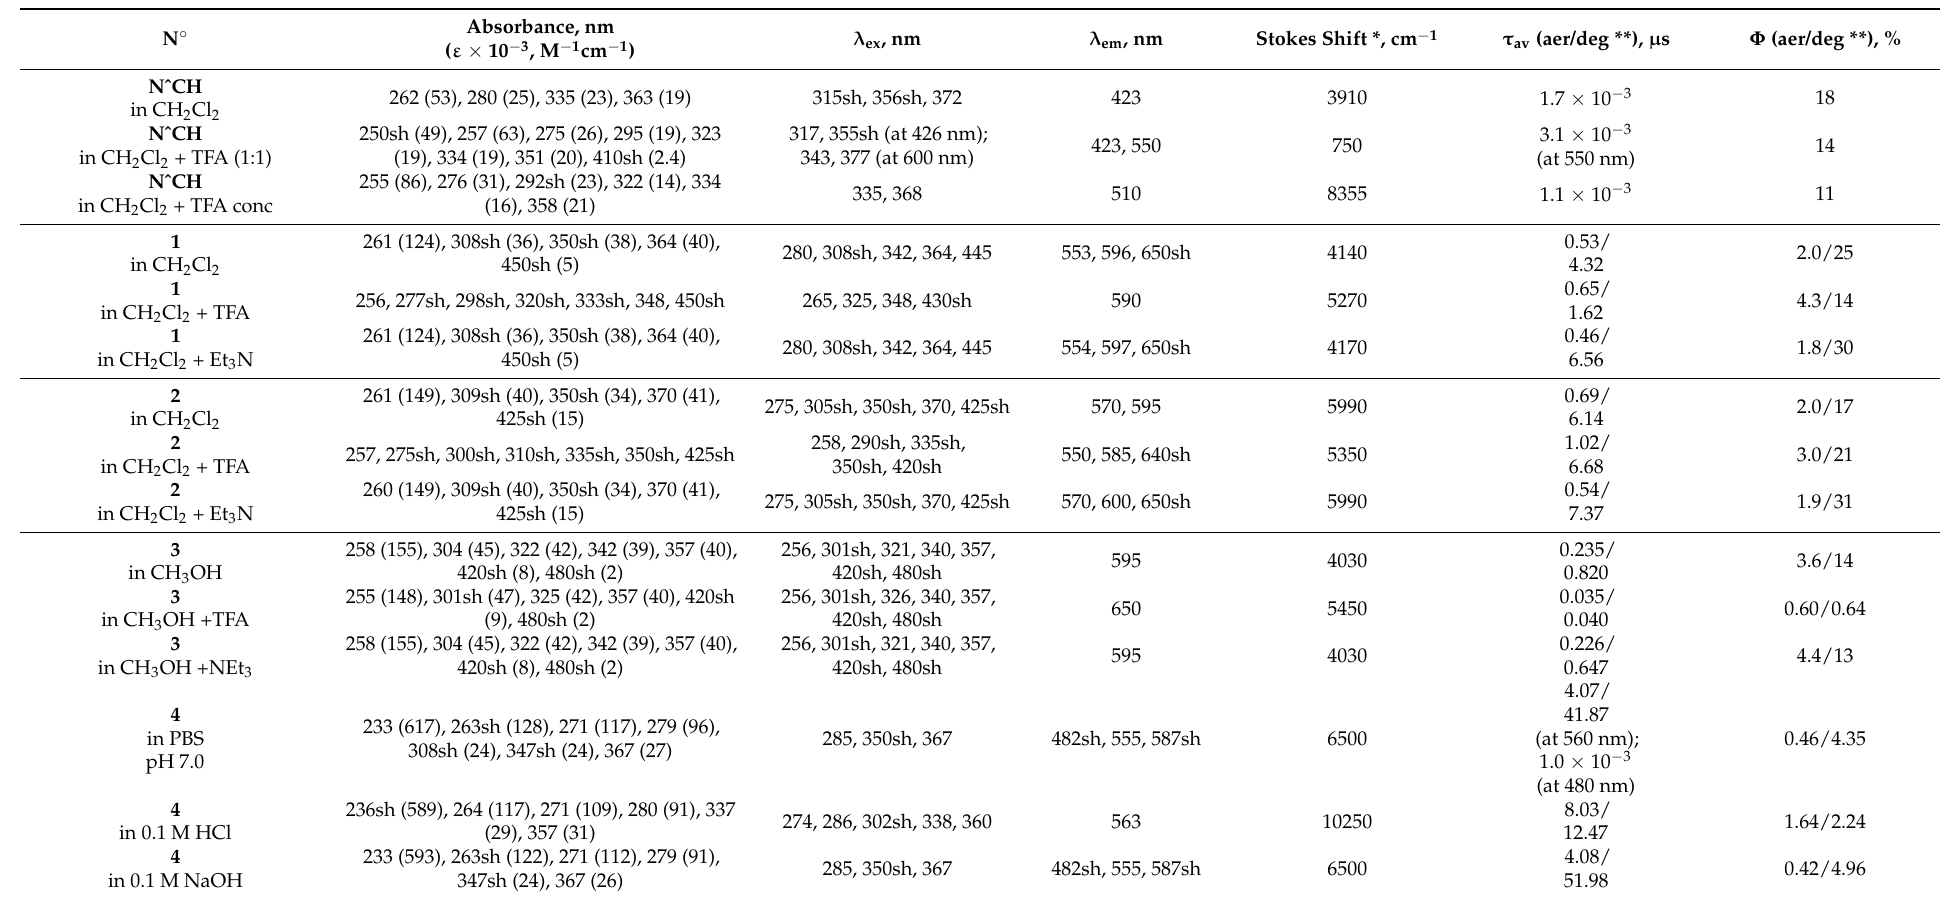
Table 1. Photophysical properties of complexes 1 and 2 , and ligand precursor NˆCH in CH 2 Cl 2 , complex 3 in methanol, and complex 4 in aqueous solutions, 298